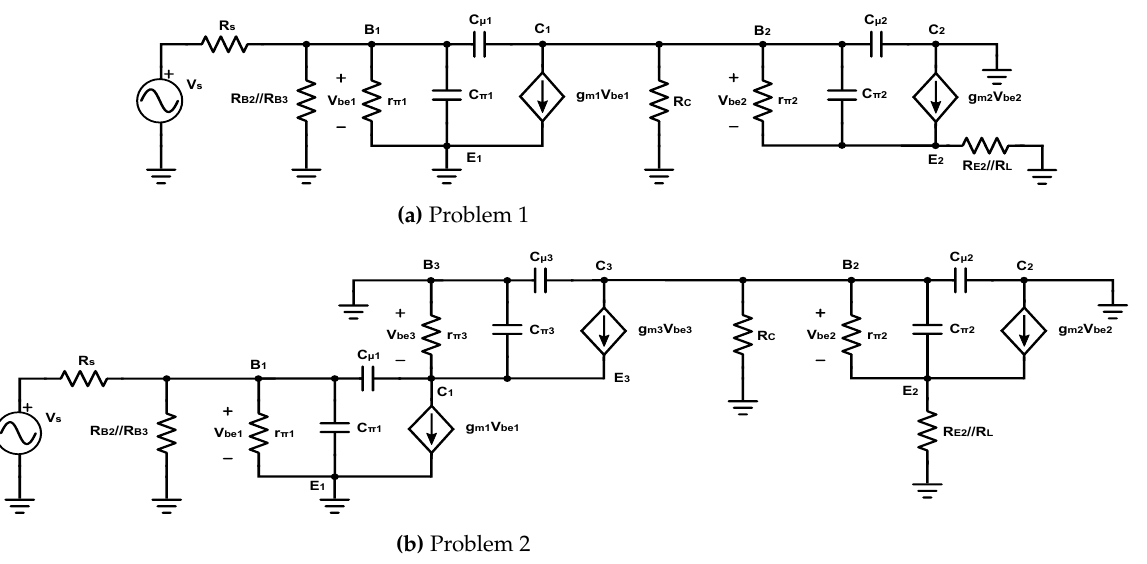
Figure 4. AC equivalent circuits of the amplification stages used in the two problems: ( a ): Problem 1. ( b ): Problem